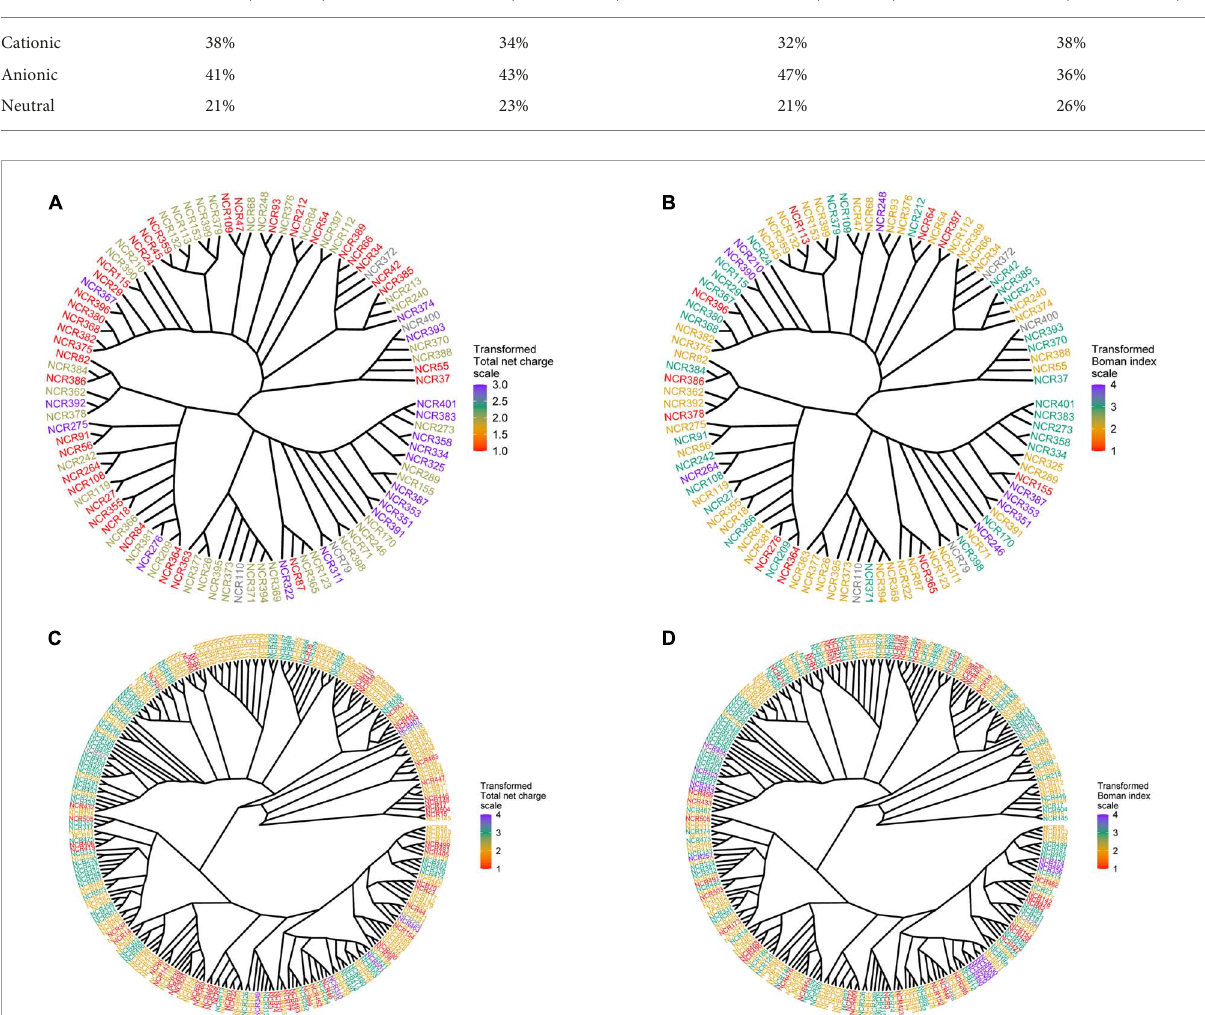
FIGURE3 Phylogenetic trees built for groups A and B of NCR genes. Each terminal node was colored according to one of the physicochemical properties. (A) Phylogenetic tree for group A colored according to the total net charge values. (B) Phylogenetic tree for group A colored according to the Boman index values. (C) Phylogenetic tree for group B colored according to the total net charge values. (D) Phylogenetic tree for group B colored according to the Boman index